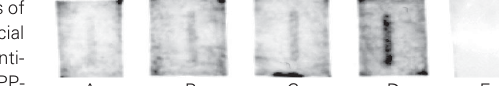
2. Immunoblot analysis of DPP-IV (CD26) using commercial polyclonal goat anti-DPP-IV anti- body (Santa Cruz). A and B , DPP- IV purified from porcine kidney (0.4 µg and 0.8 µg; Sigma). C and D , DPP-IV purified from the S17 murine bone marrow stroma cell line (50 and 100 µg). E , negative control for the secondary anti-goat